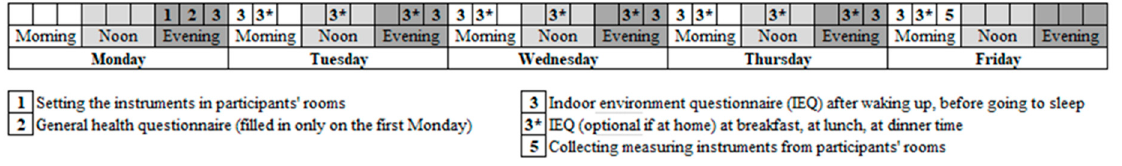
Table 1. Measuring devices.